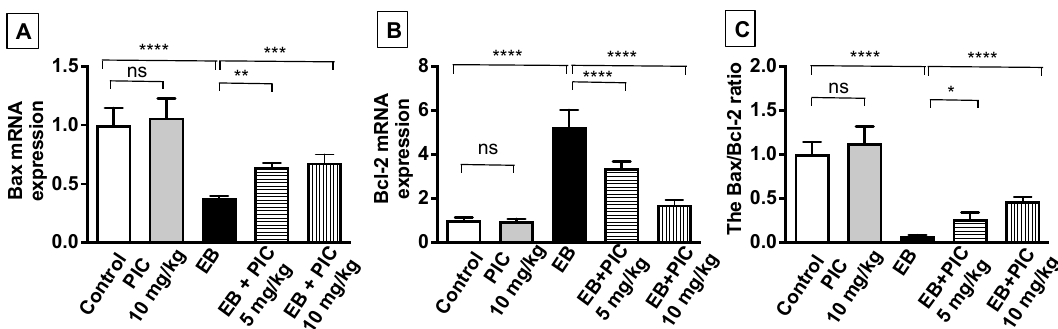
Figure 3. The effect of PIC SNEDDS treatment on the mRNA expression of Bax ( A ) and Bcl-2 ( B ) and the Bax/Bcl-2 ratio ( C ) in the uterine tissue. Data are shown as Mean ± S.D ( n = 6). ns = not significant, **p<0.01, ***p<0.001 and ****p<0.0001 by one-way ANOVA with Tukey’s post hoc test.